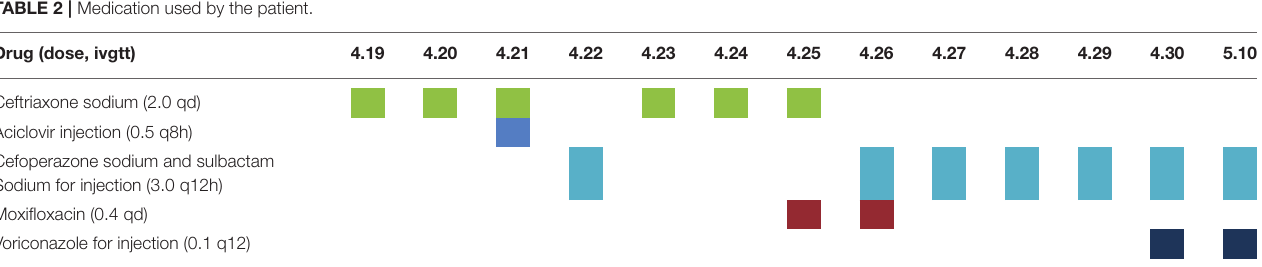
TABLE 2 | Medication used by the